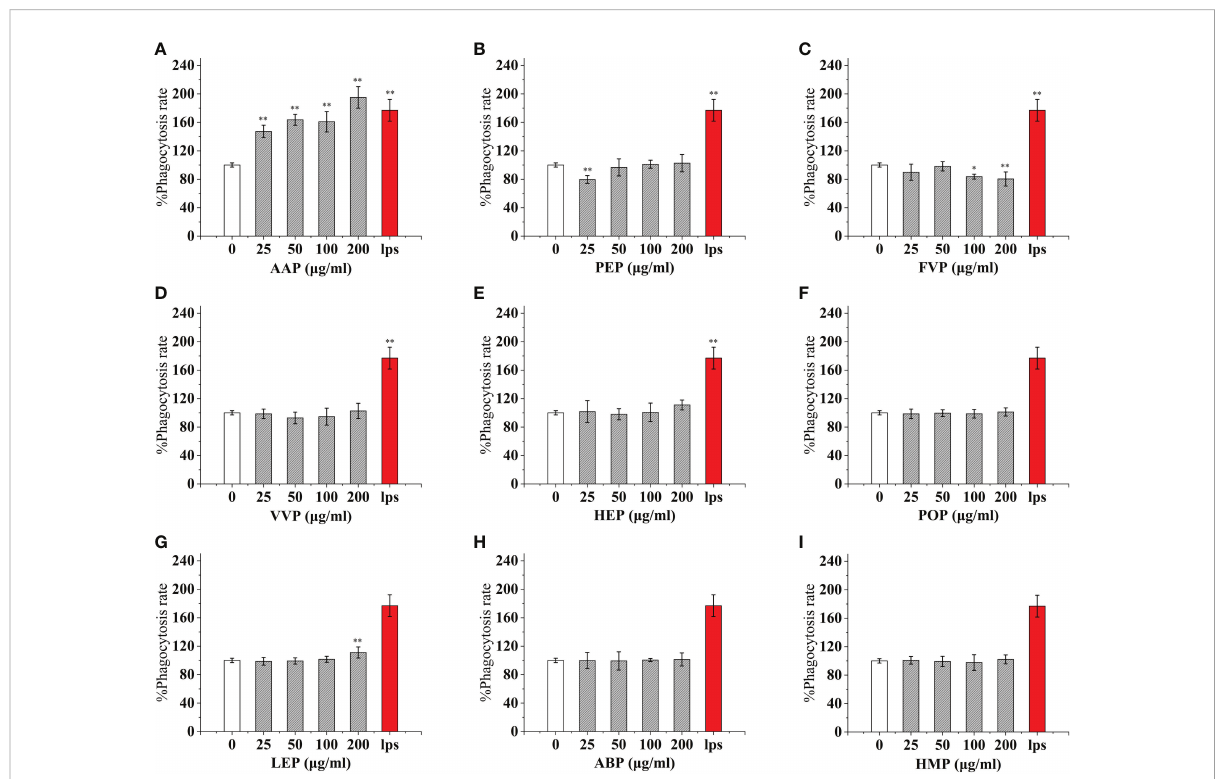
FIGURE 6 Effect of different edible mushroom protein treatments on ROS production in RAW 264.7 cells AAP (A) , PEP (B) , FVP (C) , VVP (D) , HEP (E) , POP (F) , LEP (G) , ABP (H) and HMP (I) on RAW 264.7 cells for ROS production. Data are expressed as mean ± SD (n=5). *P < 0.05 and **P < 0.01 compared to the control